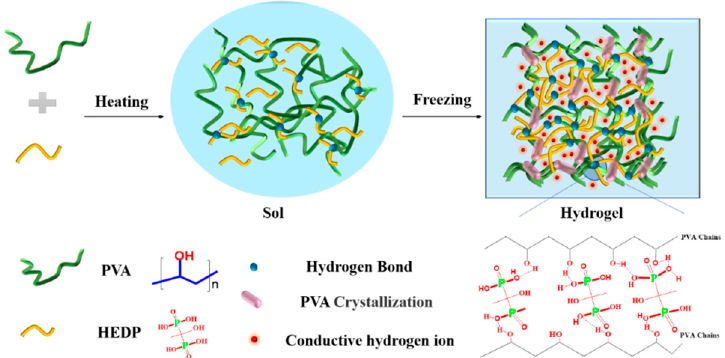
Figure 1. Scheme for the formation of the PVA-HEDP hydrogels by only one freeze–thaw cycle.